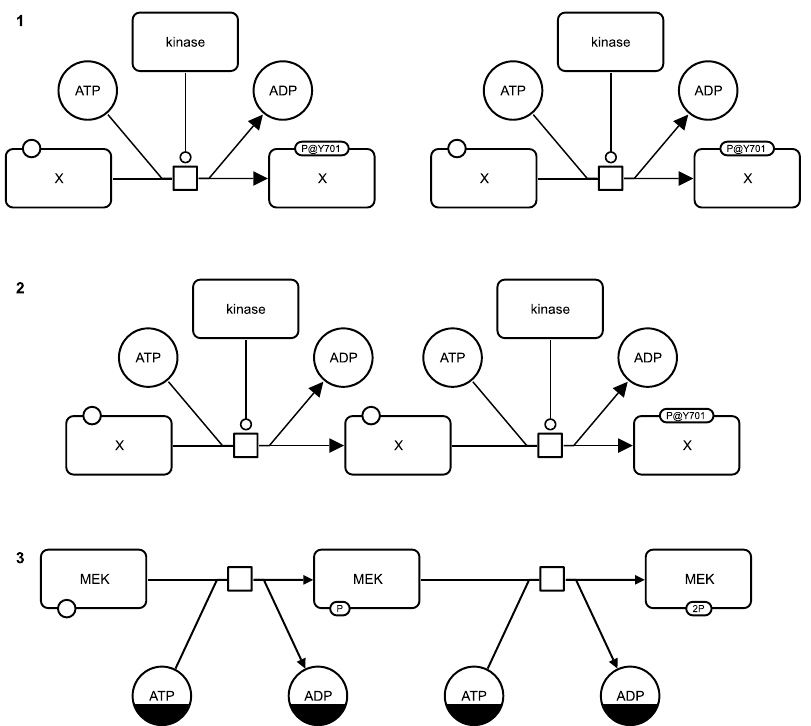
Figure 7: Example for the design of a SBGN PD map using SBGN PD bricks. The two processes in the middle of Figure 4 are assembled using the brick for protein phosphorylation: (1) the template for the protein phosphorylation is placed twice on the canvas, (2) the two glyphs in the centre are merged into one glyph, (3) the labels of the glyphs are changed. Additionally, the layout is adjusted manually. Notes: The glyph ‘‘kinase’’ has been removed from step 3 since it is redundant and is provided by the brick for the first process (not shown here). For a valid SBGN map the glyphs ‘‘ATP’’ and ‘‘ADP’’ require the clone marker , an SBGN concept indicating that a glyph appears multiple times on a map.